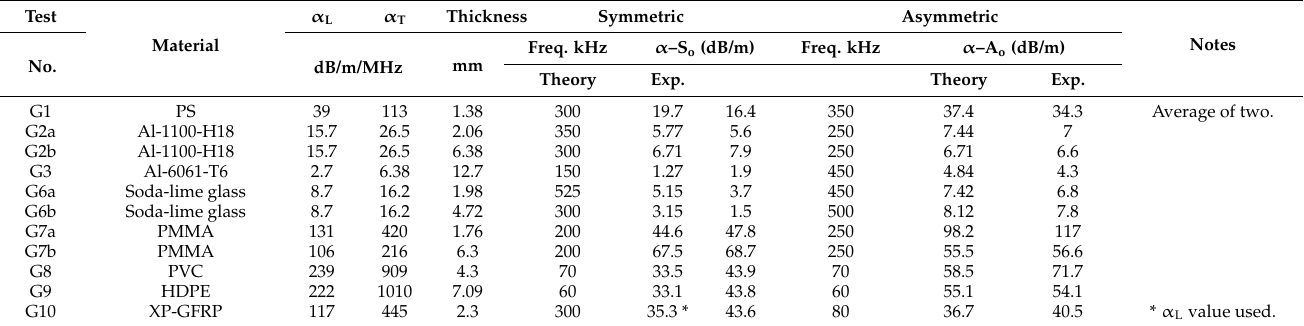
Table 2. Summary of Lamb wave attenuation values at approximate center